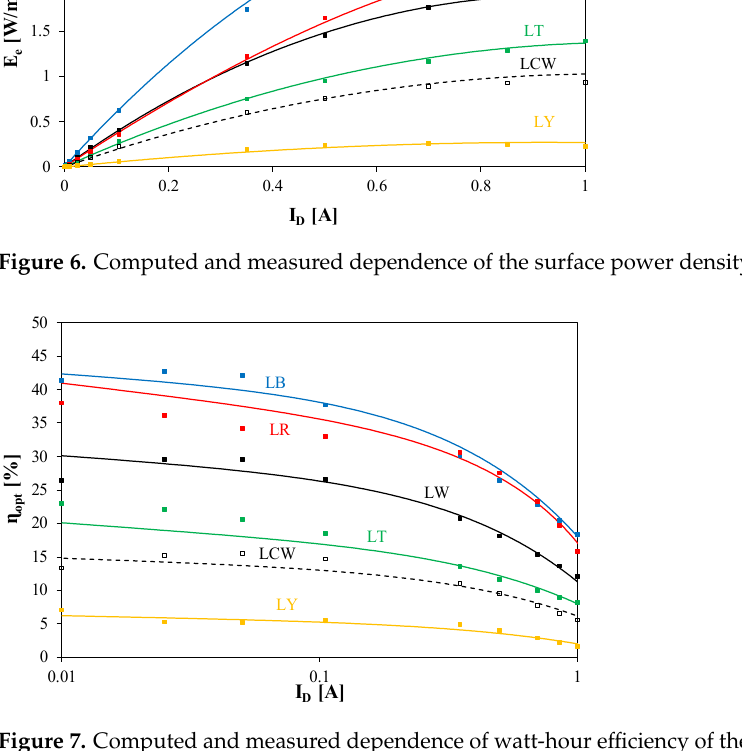
Figure 7. Computed and measured dependence of watt-hour efficiency of the conversion of electrical energy into light in the investigated power LEDs on forward current.